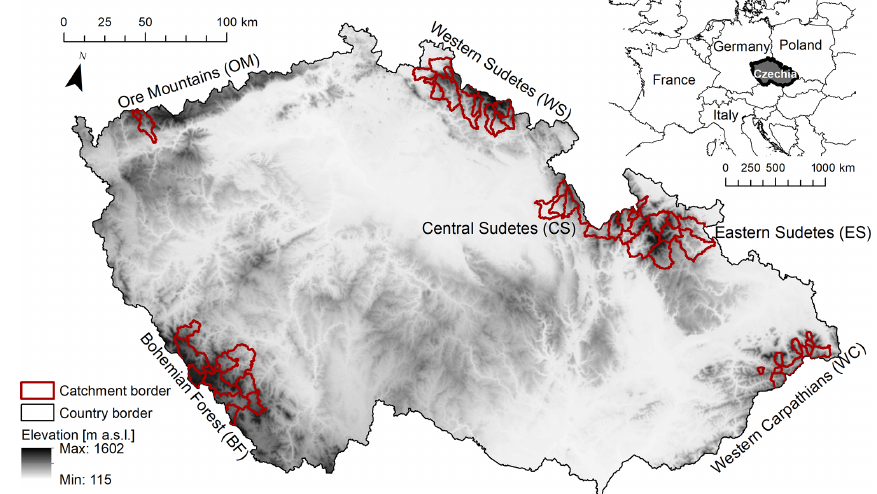
Figure 1. Location of the study catchments in